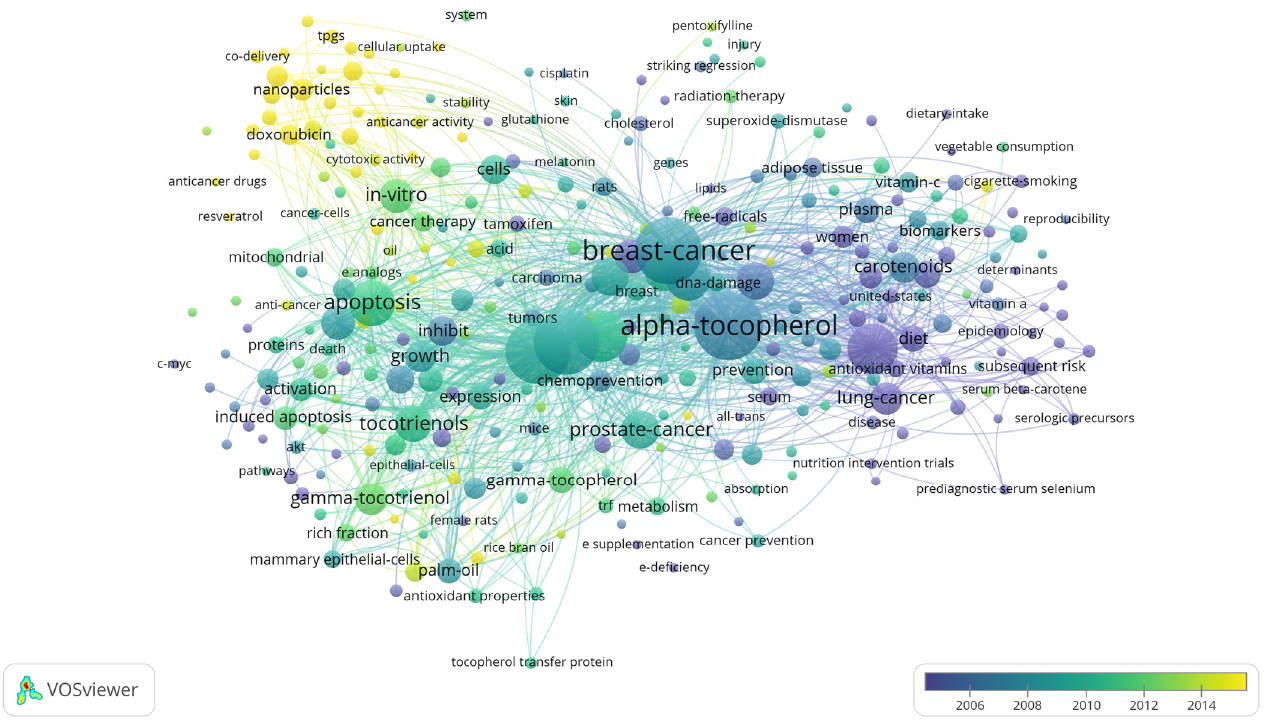
Figure 5. Term map for years 2005–2015 generated from Search 3. Visualization of 311 terms that occurred a minimum of 5 times in publications. Table S4 lists the visualized terms and their respective occurrences, average year of publication, and average number of citations.